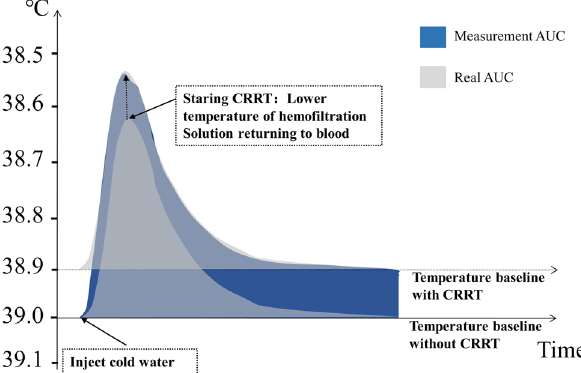
Figure A1: Changes of the AUC detected by PICCO at T1. The mea - sured AUC was bigger than the real